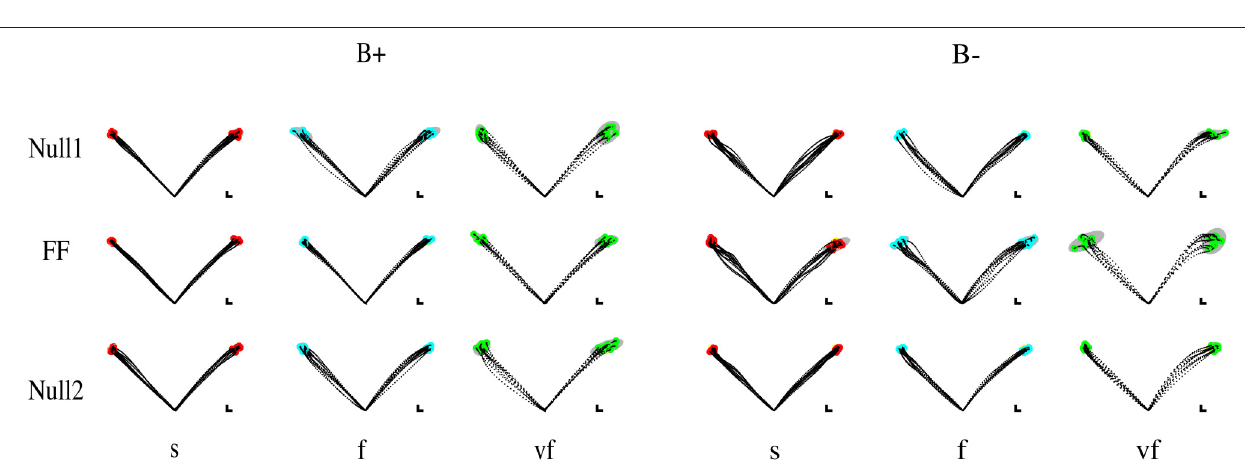
FIGURE 3 | Sample movements for different speeds, phases, and field directions, in two typical subjects in groups B + (left) and B − (right). Rows denote the different phases (from top to bottom, Null1, Field, and Null2). The columns refer to different speeds (from left to right: slow, fast, very fast), with end point displayed in red (slow), cyan (fast), and green (very fast) and with 99 % confidence ellipses of final hand position in